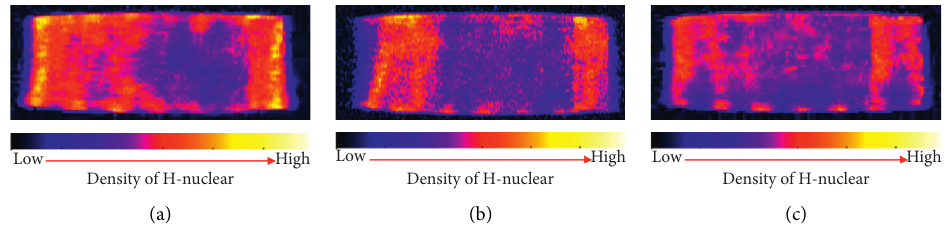
Figure 14: Coronal map of nuclear magnetic imaging of rock samples eroded by different chemical solutions: (a) acid erosion; (b) alkaline erosion; (c) neutral